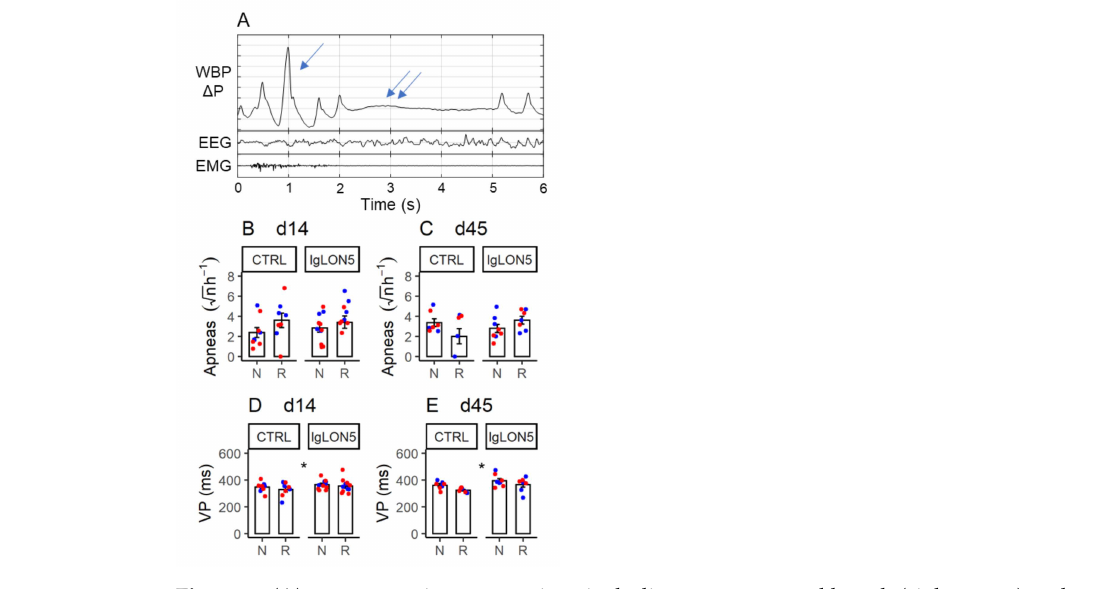
Figure 6. ( A ): representative raw tracings including an augmented breath (sigh, arrow) and a missed breath (apnea, double arrow) during NREM sleep in a female hTau mouse upon termination of the 14-day period of intracerebroventricular infusion with antibodies from a patient with anti-IgLON5 disease. WBP ∆ P: pressure difference between whole-body plethysmograph chambers, representing the breathing signal (inspiration upwards). EEG: electroencephalogram. EMG: electromyogram. ( B , C ): square-root transformed number of apneas per hour of NREM (N) or REM (R) sleep time. ( D , E ): ventilatory period (VP) during N and R. ( B–E ): data from female wild-type (blue) and hTau (red) mice infused with antibodies from patients with anti-IgLON5 disease (IgLON5) or from con- trol (CTRL) subjects. ( B , D ): data obtained at the end of the 14-day infusion (d14). ( C , E ): results obtained ≥ 1 month afterward (d45). Bars show means ± SEM. Dots show values in individual mice. * p < 0.05, ANOVA main effect of IgLON5 vs. CTRL antibodies. Detailed statistical results are reported in Tables A8 and